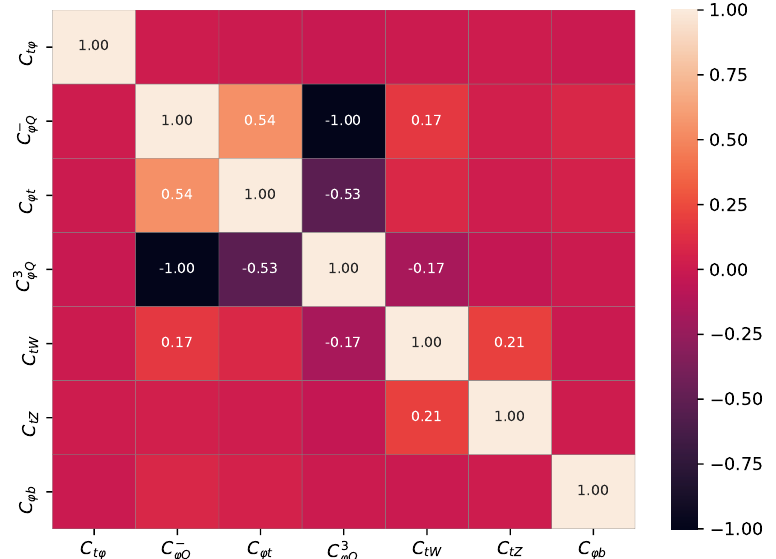
Figure 7 . Correlation matrix between the different EFT operators obtained in the baseline linear (Λ − 2 ) fit. Cells are filled if the correlation is higher than 10% in absolute value. The operator O ϕb , that modifies only the bottom quark electro-weak couplings, is taken into account in the fit but limits on its coefficients are not reported since the obtained values are not competitive using only the observables considered in our fit.